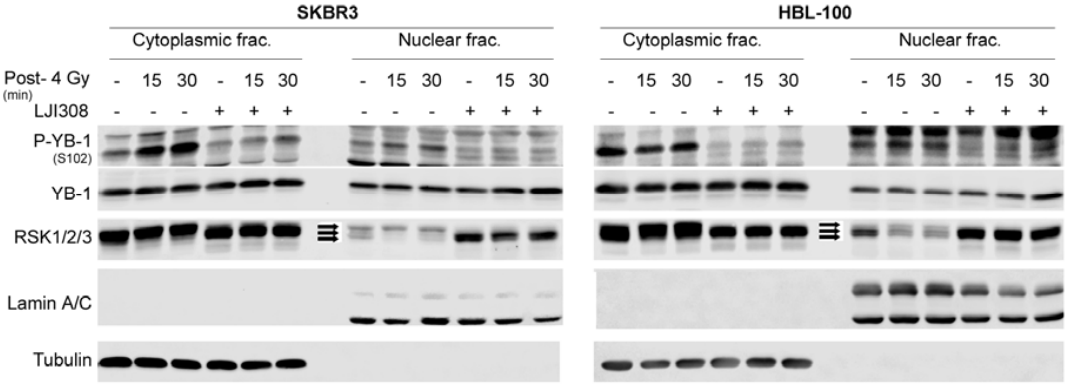
Figure 3. Targeting RSK inhibits radiation-induced YB-1 phosphorylation in nuclear fractions without affecting YB-1 nuclear level. SKBR3 and HBL-100 cells were treated with or without the RSK inhibitor LJI308 (both 5 µM, 2 h). At the indicated time-points after IR, cytoplasmic and nuclear protein fractions were prepared, and P-YB-1, YB-1, and RSK1/2/3 were detected by Western blotting. α -Tubulin and Lamin A/C were detected as cytoplasmic and nuclear markers, respectively. Arrows indicate distinct RSK isoforms.